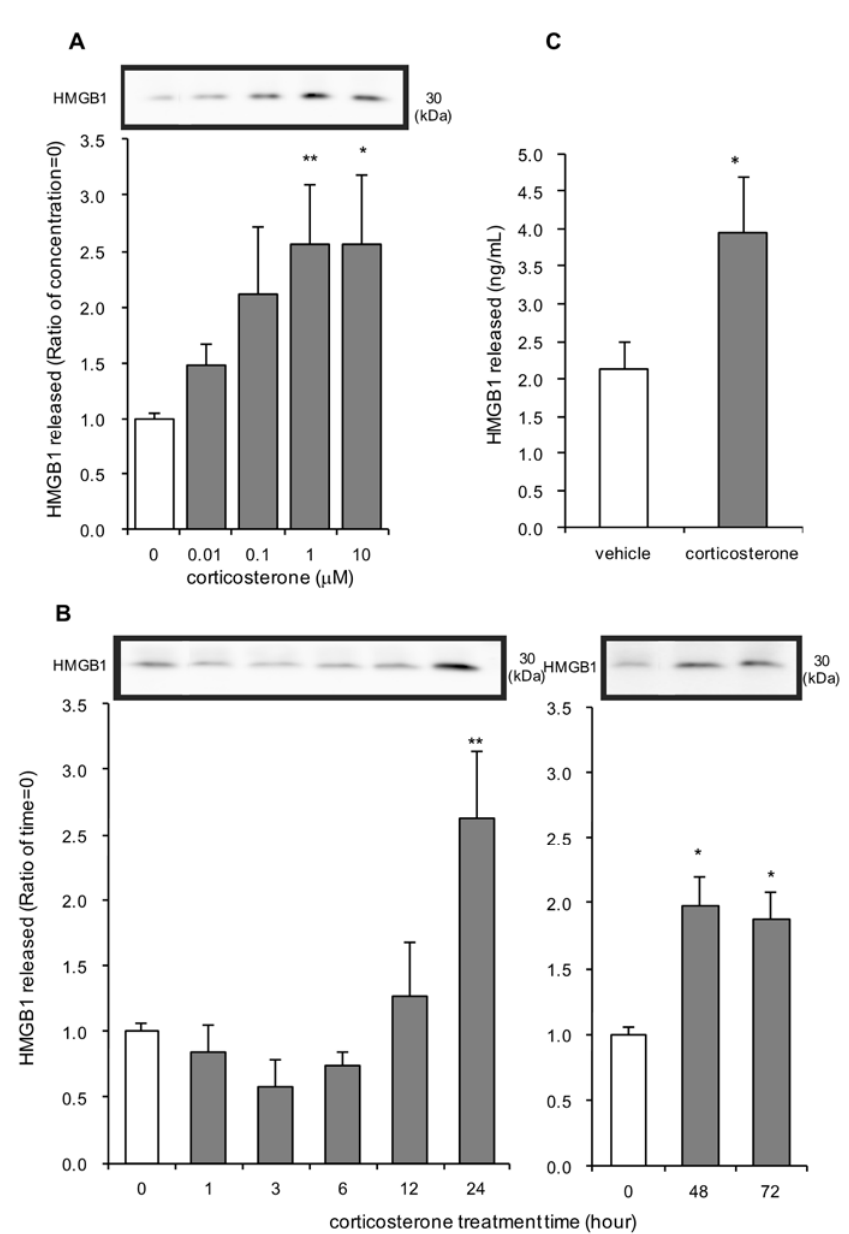
Figure 1. The e ff ect of corticosterone on high-mobility group box-1 (HMGB1) release in primary cultured cortical astrocytes. ( A ) Increasing concentrations of corticosterone induced HMGB1 release from astrocytes. Cells were treated with the indicated concentrations of corticosterone for 24 h, and the amount of HMGB1 in the media was analyzed by Western blotting. Representative blots are shown (HMGB1: 30 kDa). The data are expressed as the mean ± SEM. * p < 0.05, ** p < 0.01 vs. basal (concentration “0”) (Dunnett’s test; n = 7–15). ( B ) Astrocytes were treated with 1 µ M corticosterone for the indicated periods of time and the amount of HMGB1 in the media was analyzed by Western blotting. Representative blots are shown (HMGB1: 30 kDa). The data are expressed as the mean ± SEM. * p < 0.05, ** p < 0.01 vs. basal (time “0”) (Dunnett’s test; n = 3–15). ( C ) Astrocytes were treated with 1 µ M corticosterone for 24 h, and media concentrations of HMGB1 were analyzed by ELISA. The data are expressed as the mean ± SEM. * p < 0.05 vs. vehicle ( t -test; n =